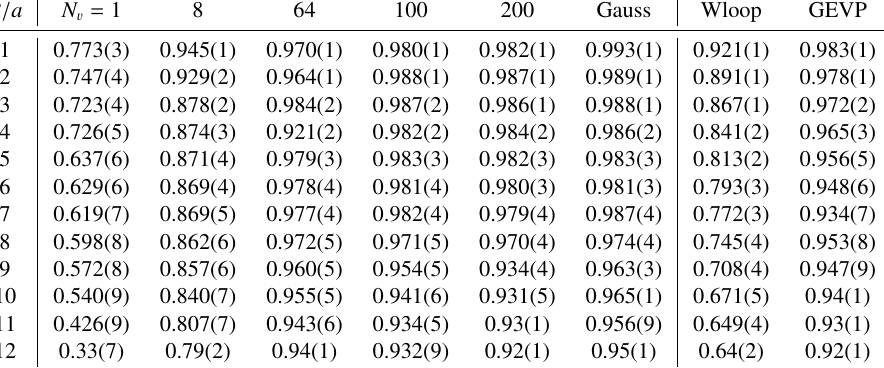
Table 1. Fractional overlaps with the corresponding ground state energies aV 0 ( R ) from a cosh fit, Eq. (3), see also [26]. In general, an increasing number N v of Laplacian eigenvectors enhances the overlap up to about N v ≈ 100 and are already better for N v = 8 than standard Wilson loops (column 7). The overlaps for Laplace trial states from a GEVP with Gaussian profiles in the 6th column are better than Wilson loop results from a GEVP with di ff erent spatial HYP smearing levels (column